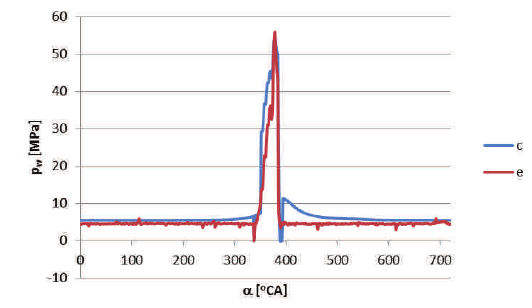
Fig. 10. The pressure course of in the injection pump measured in experi- mental studies (e) and calculated (c) for the 100% of the engine load